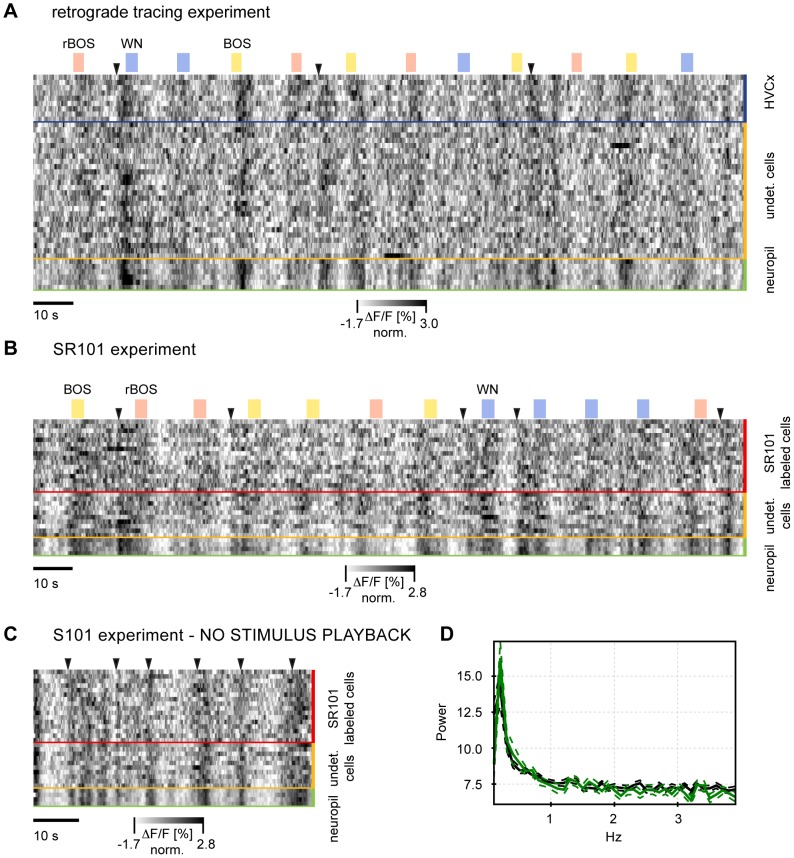
Stackplots of ΔF/F traces in ROIs of different types reveal synchronous activity.
A Experiment with labeled HVCX neurons, B experiment with labeled astroglia. A and B: Auditory responses modulate ongoing strong baseline signal fluctuations that are highly synchronized across the entire network. Many synchronized ΔF/F transients occur in the absence of auditory stimulation (black arrows). Stimulus playbacks are indicated on top. Each line represents the ΔF/F signal normalized by the standard deviation of that ROI, the darker the shading, the larger the ΔF/F values. Stimulus playbacks are indicated on top (blue: WN, red: rBOS, yellow: BOS). C Stackplot of spontaneous activity (no auditory stimulation) in the same ROIs as in B reveals that synchronous ΔF/F fluctuations occur spontaneously. D Spectra of ΔF/F signals averaged over all ROIs in B (black) and C (green) with standard error of the mean (SEM) delimited by dashed lines. Both with and without auditory stimulation there are strong fluctuations at low frequencies (<1 Hz).